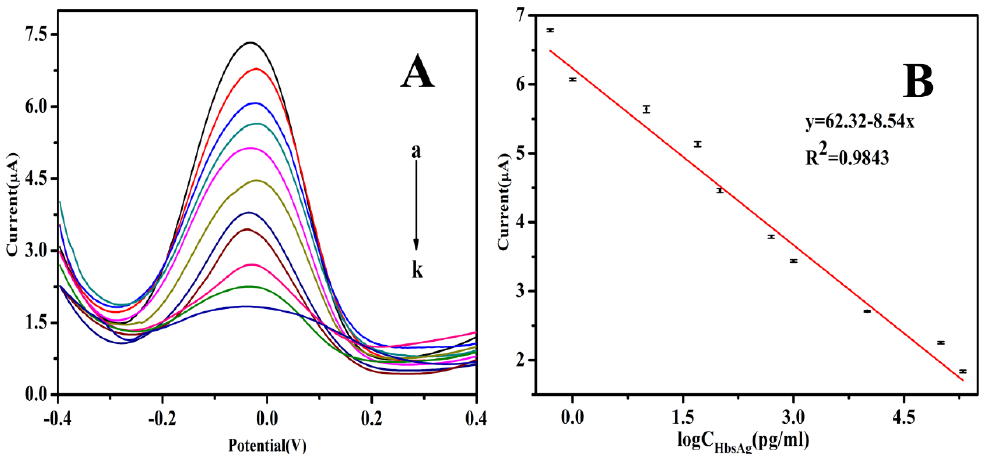
Table 1. Comparison with other reported methods for the determination of HBsAg.